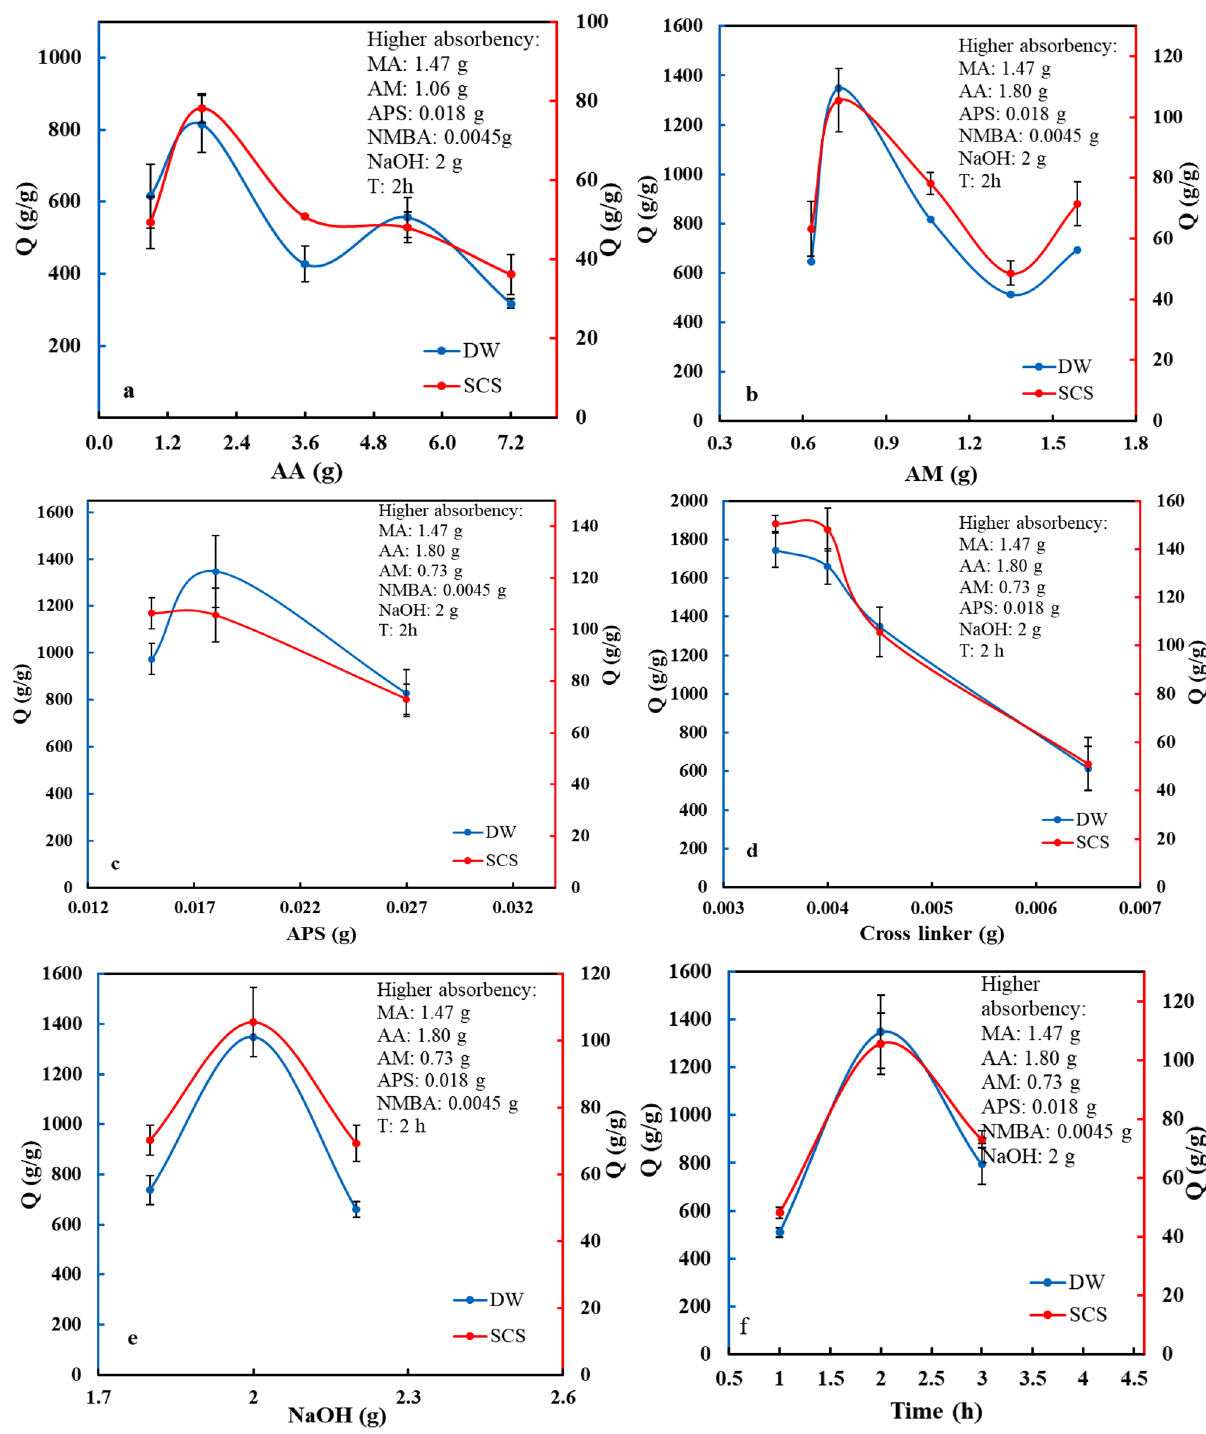
Figure 1. The water absorbency capacity of the p(AA-co-AM-co-MA) superabsorbent under the effect of the following variables: ( a ) Amount of AA. ( b ) Amount of AM. ( c ) Amount of APS initiator. ( d ) Amount of MBA cross-linker. ( e ) Neutralization amount. ( f ) Reaction time. Data for DW (blue color), Data for SCS (red